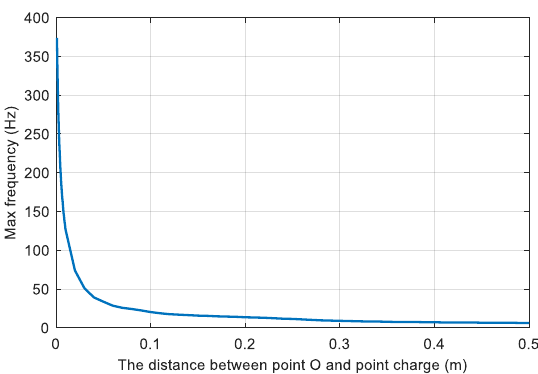
Figure 17. Variation of the main frequency and point charge position of the induced current spectrum under the action of the point charge moving at 20 m/s.